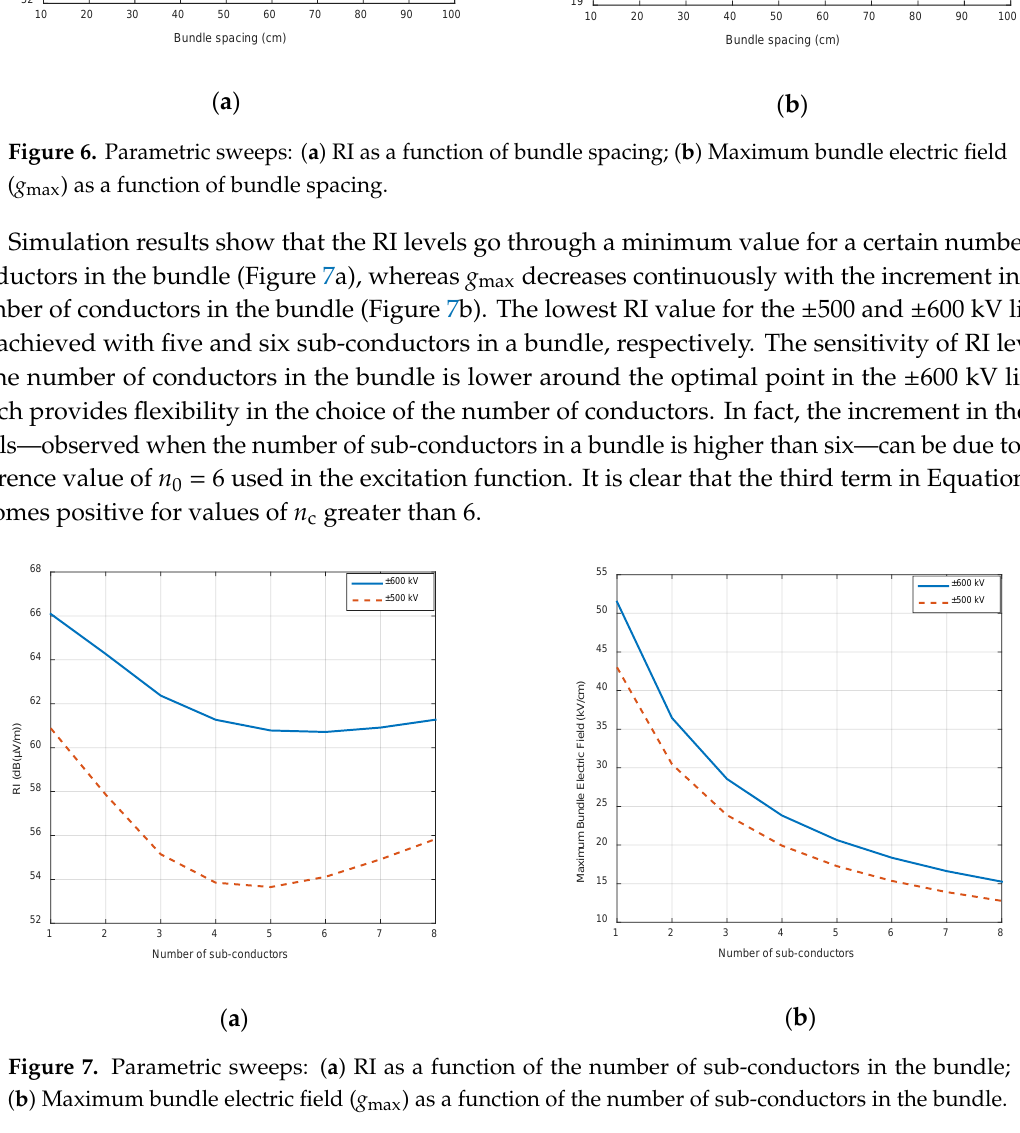
Figure 7. Parametric sweeps: ( a ) RI as a function of the number of sub-conductors in the bundle; ( b ) Maximum bundle electric field ( g max ) as a function of the number of sub-conductors in the